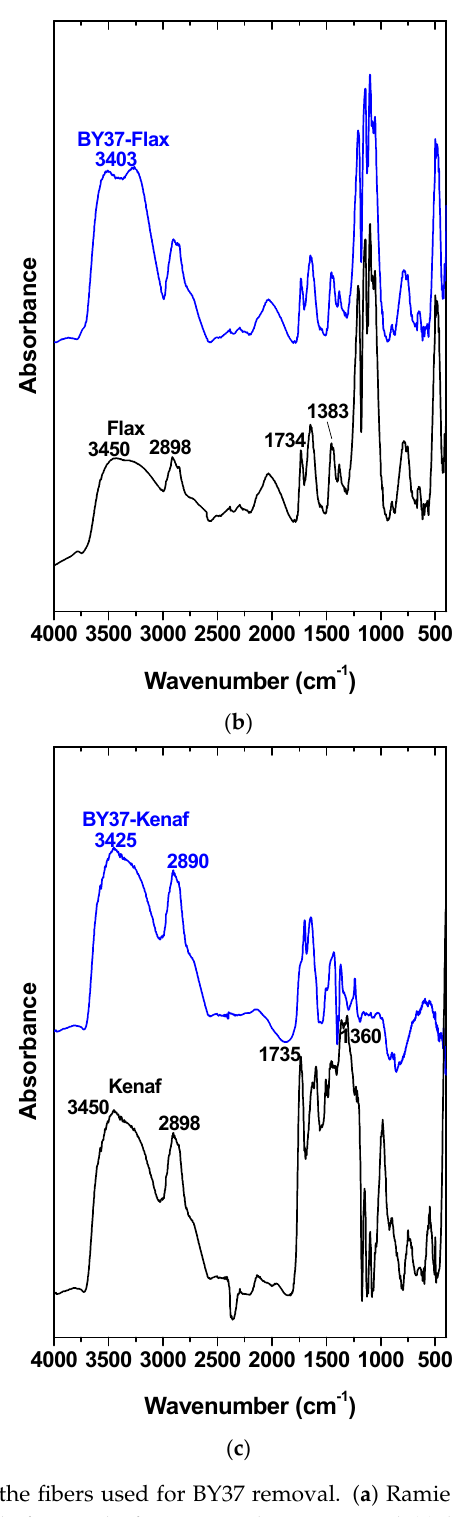
Figure 6. FTIR spectra of the fibers used for BY37 removal. ( a ) Ramie fiber before and after BY37 adsorption, ( b ) flax fiber before and after BY37 adsorption, and ( c ) kenaf fiber before and after BY37 adsorption.